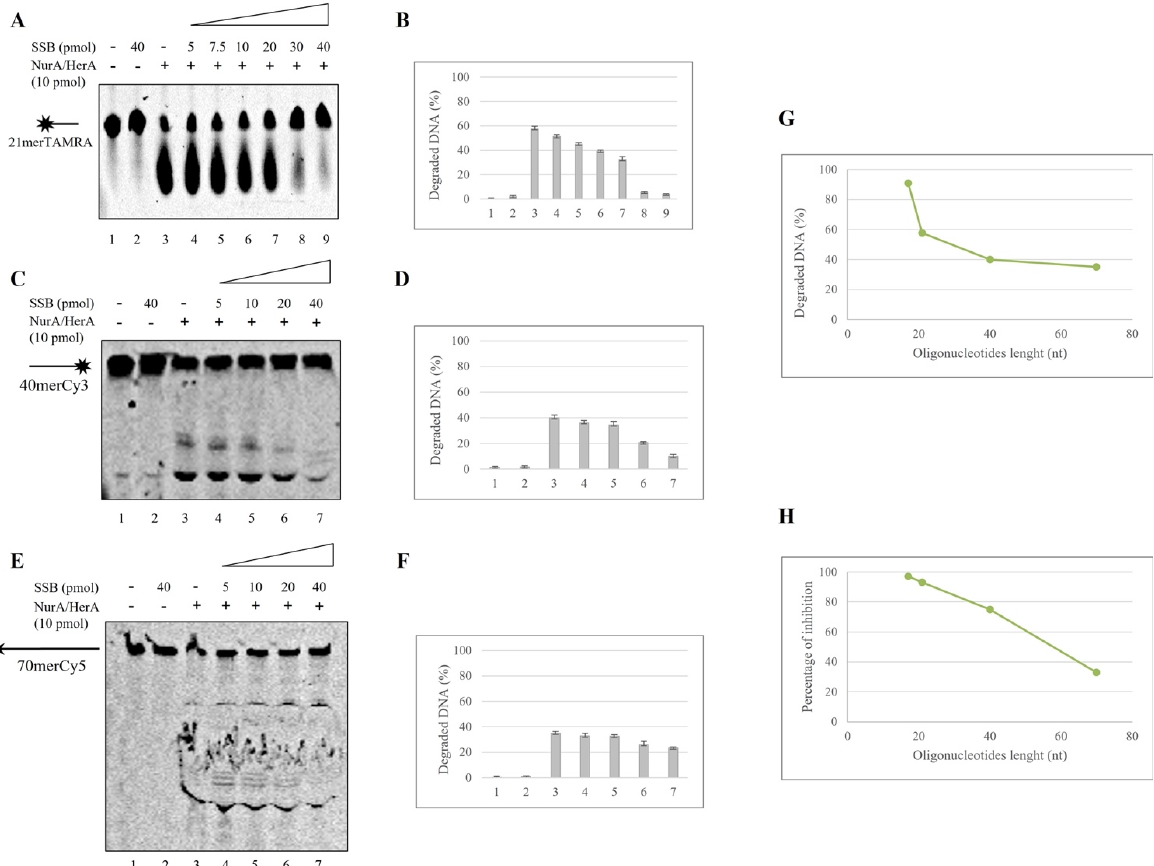
Figure 3. Effect of SSB on NurA/HerA exonuclease activity on various DNA substrates different in length. NurA/HerA exonuclease activity was tested on a 21 merTAMRA ( A ), on a 40 merCy3 ( C ) and on a 70 merCy5 ( E ) oligonucleotides in absence (lanes 3) or presence (lanes 4–9 for 21 merTAMRA; lanes 4–7 for 40 merCy3 and 70 merCy5) of increasing amounts of SSB oligonucleotide. Negative controls were performed in absence of proteins (lane 1) and presence of 40 pmol of SSB alone (lane 2). ( B , D , F ) Values obtained from the quantization of the activity on each different substrate, 21 merTAMRA ( B ), 40 merCy3 ( D ) and 70 merCy5 ( F ), are reported here; the values are the average of three different experiments. ( G ) The graph shows the trend of NurA/HerA nuclease activity (%) related to the substrate length used. ( H ) The graph shows the trend of SSB inhibition on NurA/HerA nuclease activity related to the length of the substrate analyzed.